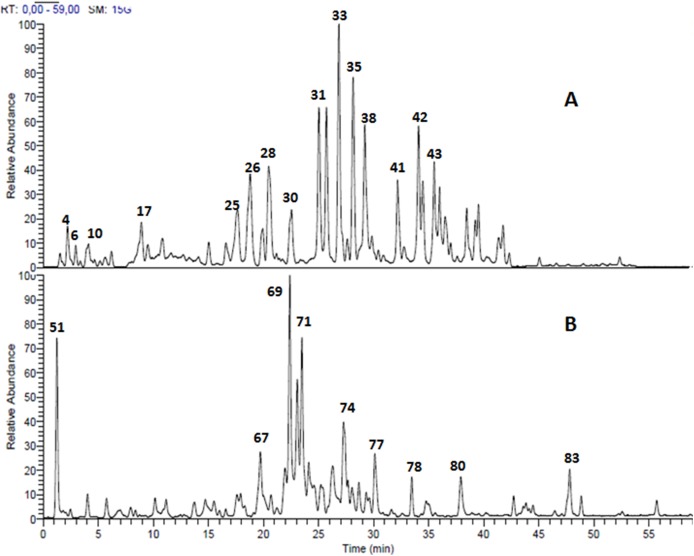
LC-MS chromatogram.Total ion chromatogram of the methanol leaves extracts (A) Terminalia bellirica, 50 compounds were separated; (B) T. sericea, 35 compounds were separated.